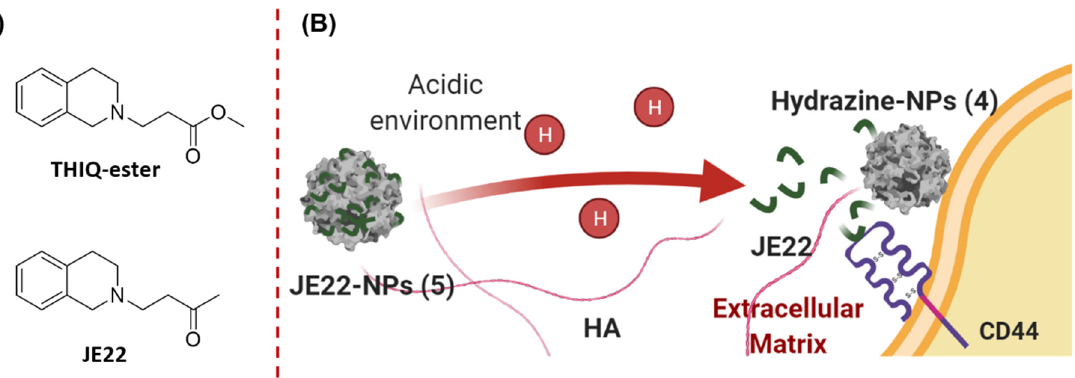
Figure 1. Schematic overview of the strategy proposed. ( A ) Chemical structures of the CD44 inhibitors. ( B ) Specific release of the THIQ inhibitor JE22 bound to the nanodevice JE22-NPs ( 5 ) as a result of the acidic environment in the cancer cells, and subsequent therapeutic activity by its binding to CD44.